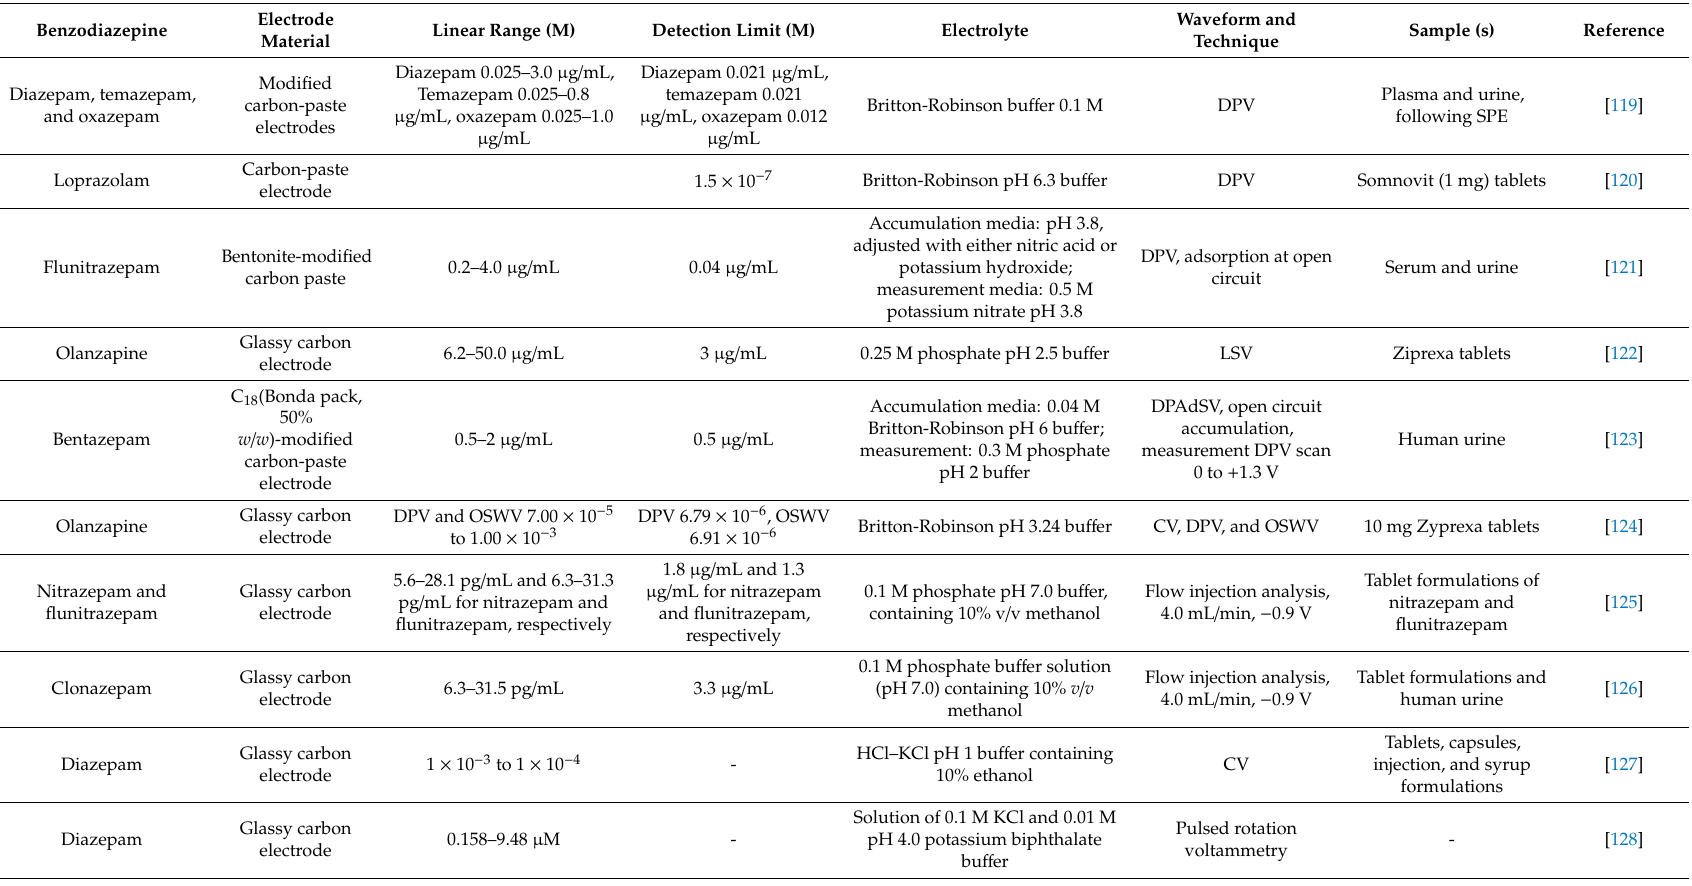
Table 2. Pre-2006 voltammetric methods for the determination of benzodiazepines at carbon-based